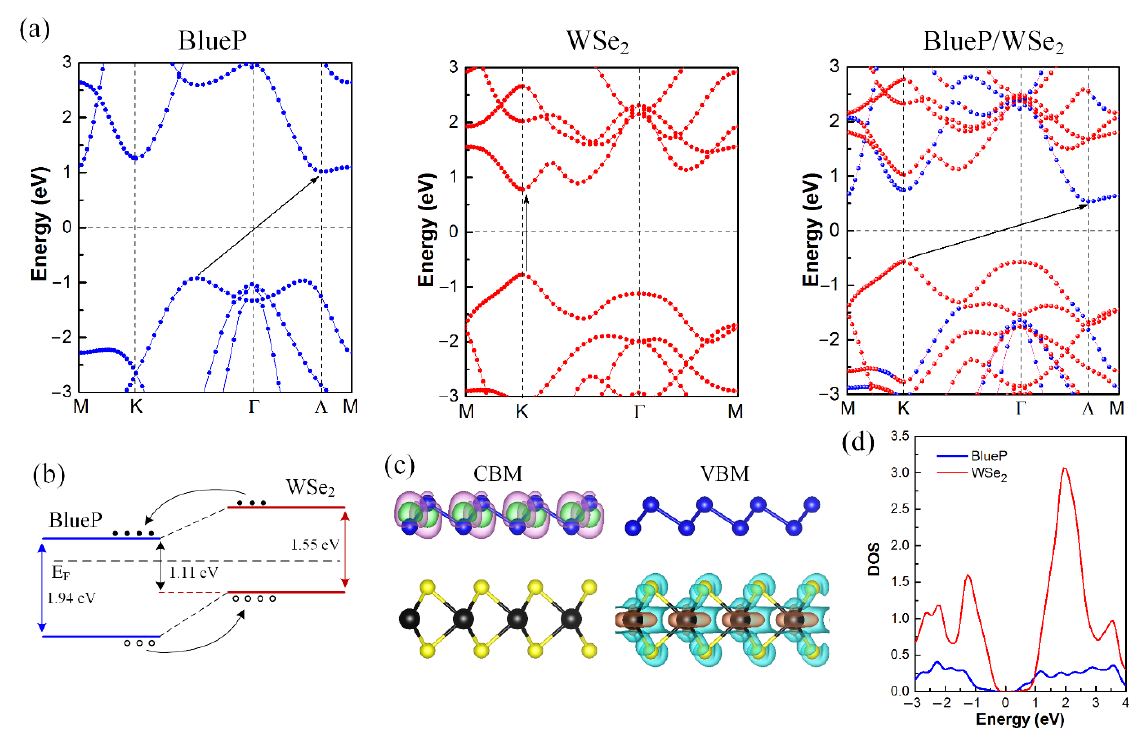
Figure 2. ( a ) Band structures of monolayer BlueP, monolayer WSe 2 , and BlueP/WSe 2 vdW heterostructure. ( b ) The band alignment, ( c ) the band decomposed charge density of CBM and VBM, and ( d ) the DOS of BlueP/WSe 2 vdW heterostruc- ture.